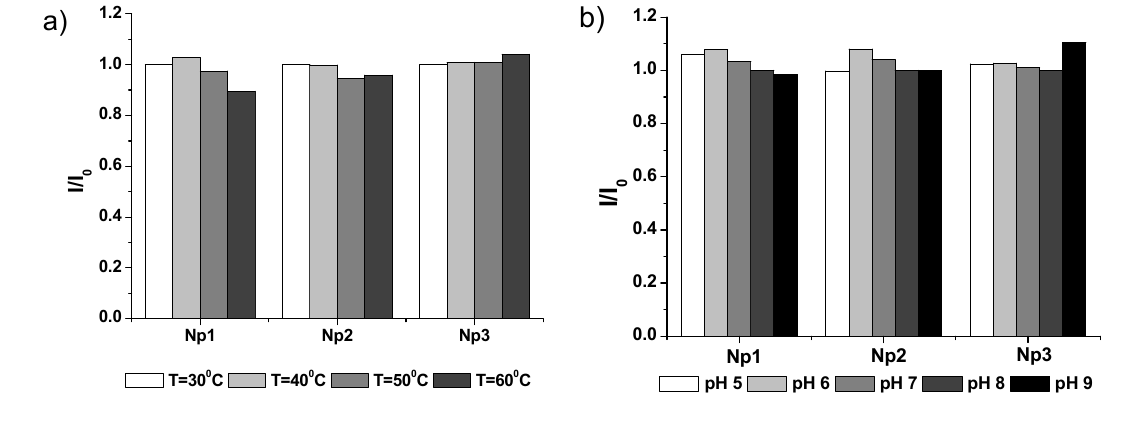
Figure 3. Relative stability of nanoparticles ( a ) at different temperatures and ( b ) in the buffers with different pH values. The Nile red fluorescence intensity of nanoparticle solutions at 30 °C, and pH 7.0 was used as the standard.